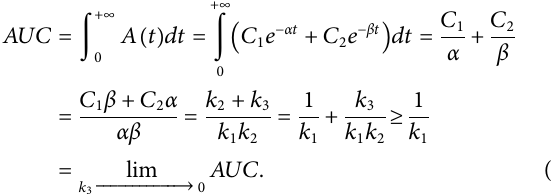
Frontiers in Environmental Science |